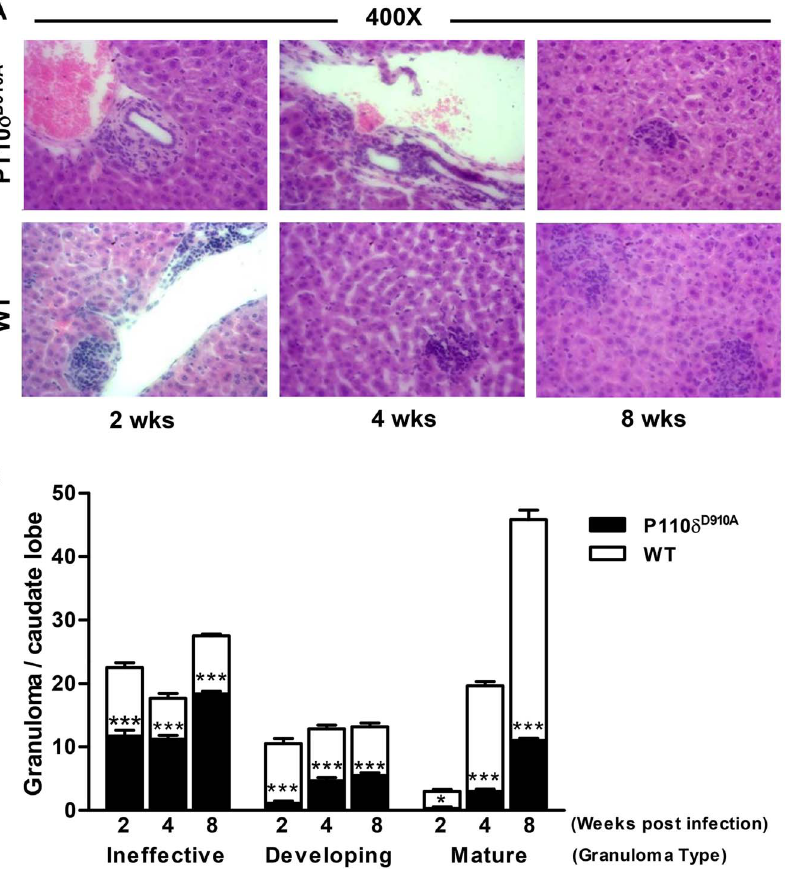
Figure 4. Enhanced resistance of p110 d D910A mice is not associated with more robust granuloma formation. Infected p110 d D910A and WT mice were sacrificed at the indicated times and their liver were processed and stained routinely to assess granuloma formation (size, cellularity and maturation) as described in the materials and methods section. The H&E stained sections (A) were assessed and scored blindly by a pathologist for the presence/number of ineffective, developing and mature granulomas and represented as a bar graph (B). Results are representative of 2 independent experiments (n = 3 mice per group) with similar results. Error bars, + / 2 SEM; *, p , 0.05; **, p , 0.01; ***, p , 0.001.